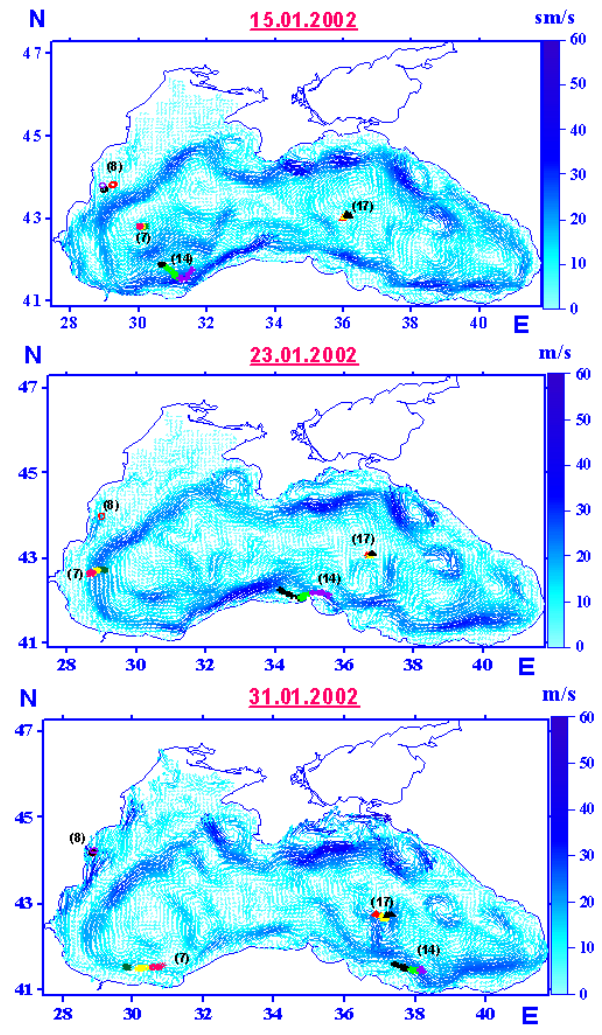
Figure 13 Trajectories of surface drifting buoys overlapped on the simulated circulation. January 2002.